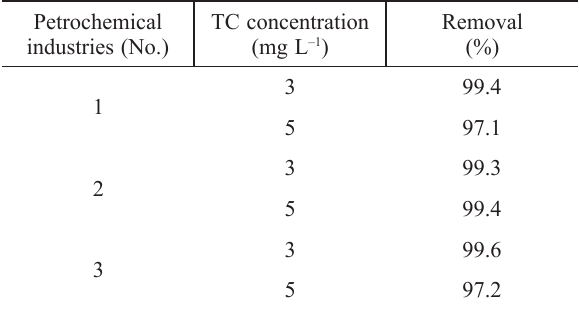
O -SDS performance for TC removal from pet- Table 2 – Fe 3 4 rochemical effluent Petrochemical industries